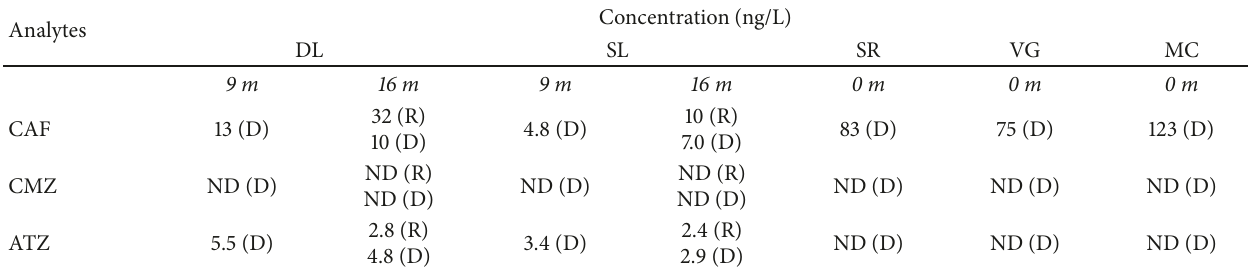
Table 7: Concentrations of caffeine, carbamazepine, and atrazine in the future water sources of the Brazilian Federal District. Analyte CL PL-C PL-E